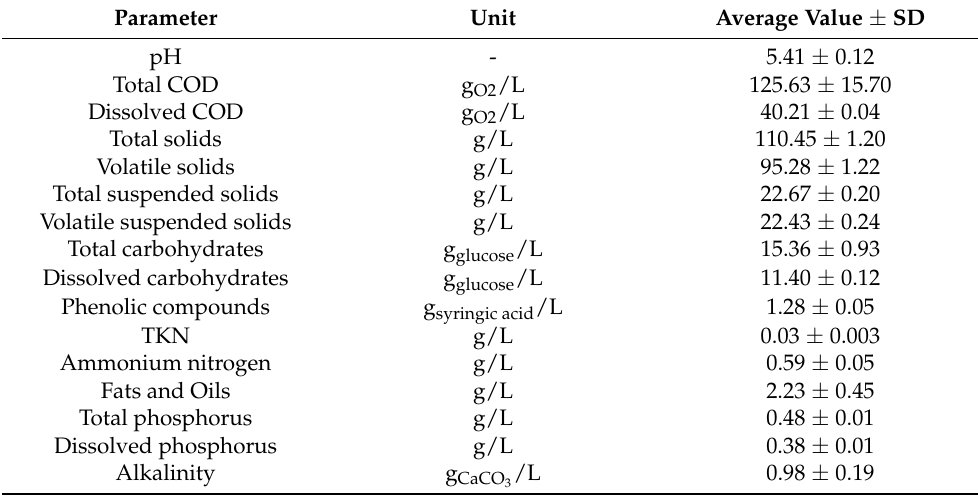
Table 4. Physicochemical characterization of the